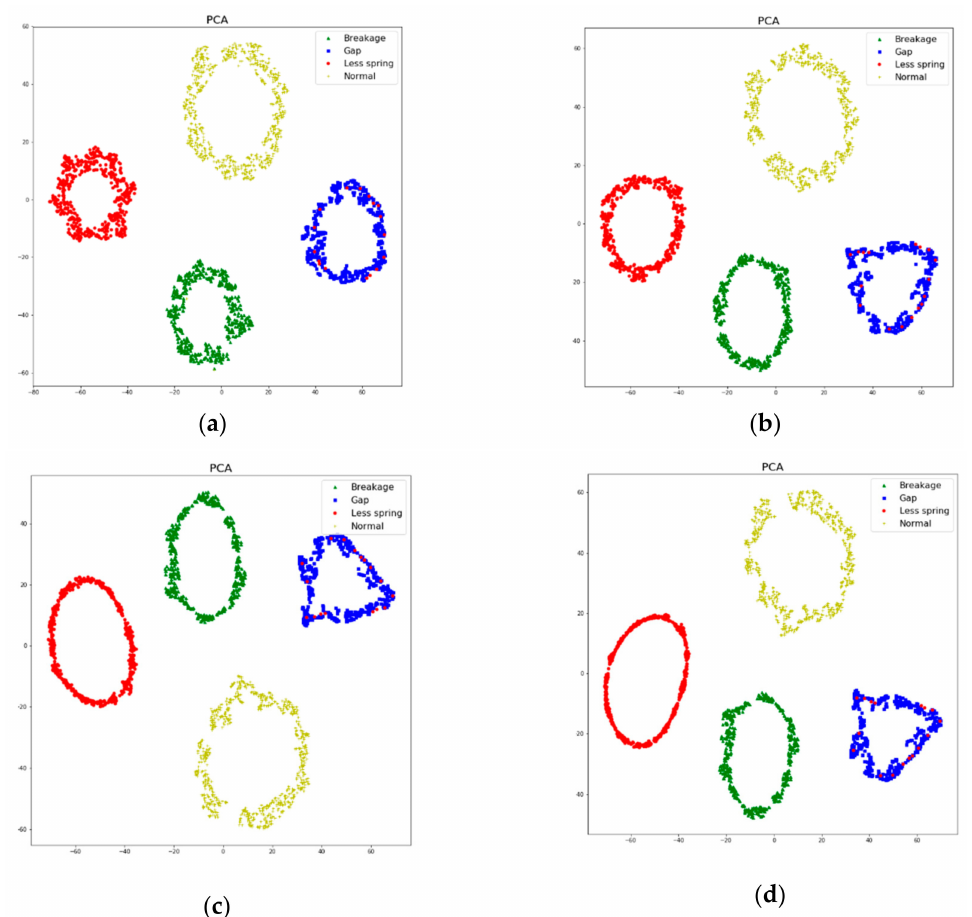
Figure 15. PCA of the output of the test set samples in the dense 1 of the 2-D CNN multi-measurement point model under di ff erent noise strengths ( a ) SNR is 5 dB; ( b ) SNR is 10 dB; ( c ) SNR is 20 dB; ( d )SNR is 50